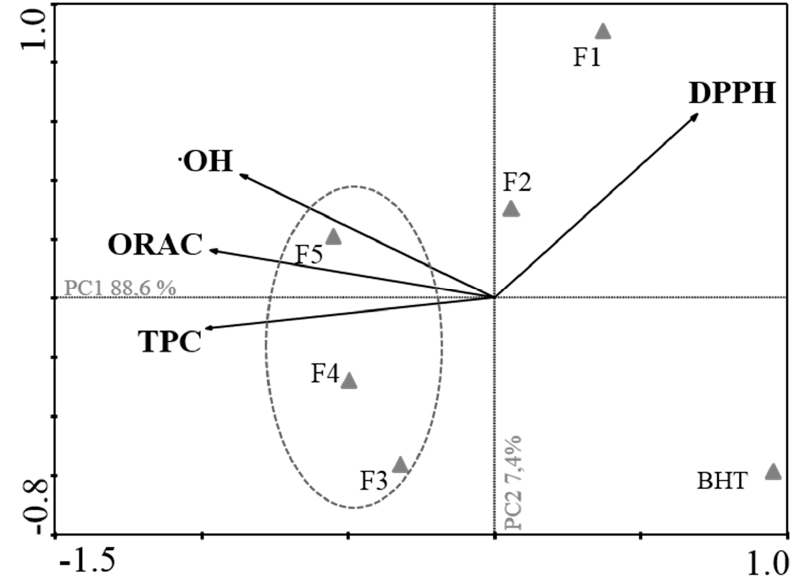
Figure 1. Principal component analysis (PCA) of total phenolic content (TPC) and antioxidant activities (DPPH, • OH and ORAC) of Fucus spiralis fractions. The vectors represent a variant existing among the antioxidant methods. The first principal component (PC1) and the second principal component (PC2) represent the total variance of the data. The circle defines a group of samples that contains the highest antioxidant activity. The triangles in the figure represent each sample distributed according to its